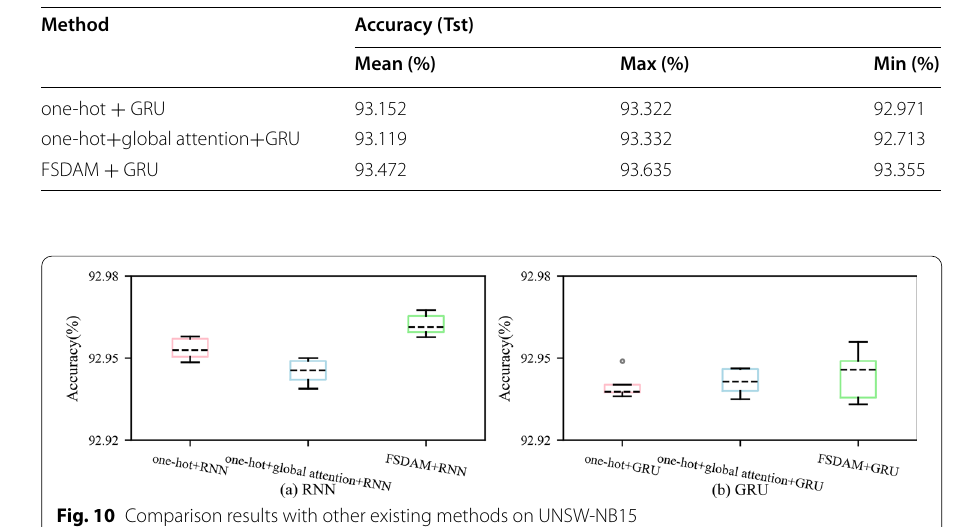
Table 16 Accuracy of different methods on AWID